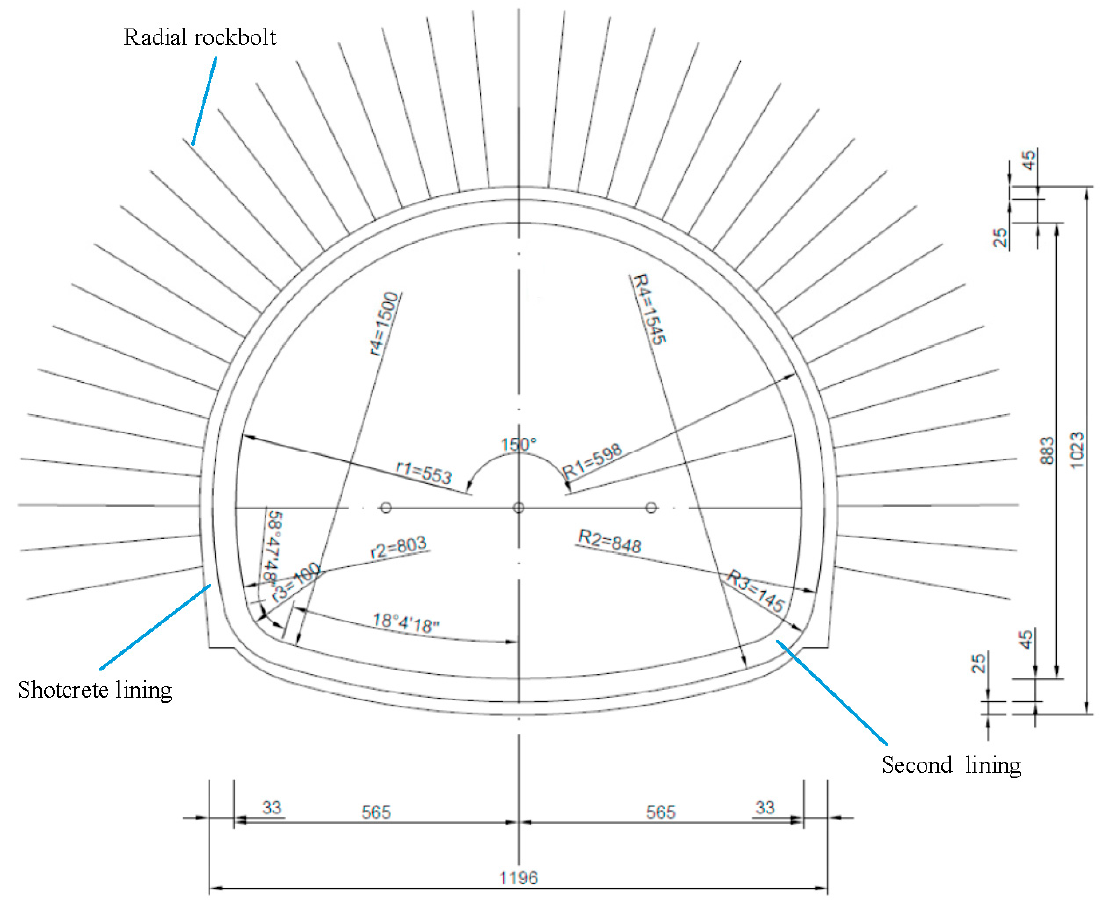
Figure 4. Initial support and second lining of tunnel (unit: cm). Table 1. Tunnel support mechanical